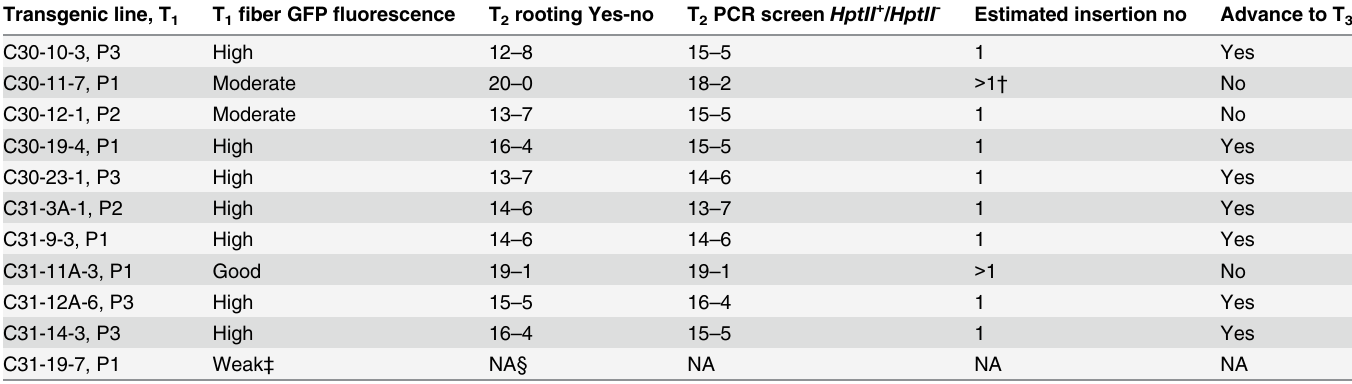
Table 2. Segregation of T 2 seedlings of selected C30 and C31 cotton transgenic lines for rooting on hygromycin-selection medium and for the presence/absence of hygromycin DNA fragment in PCR products. Transgenic line, T